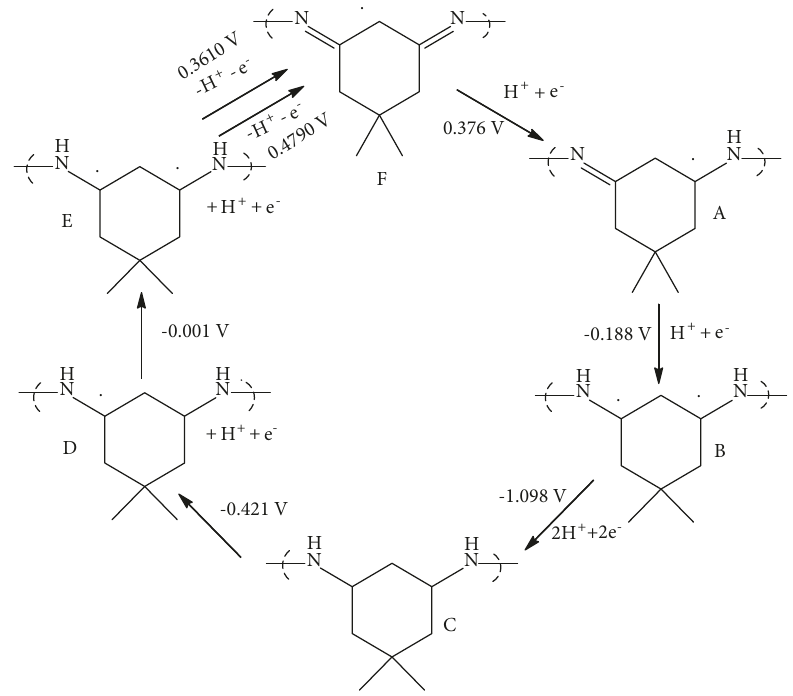
Figure 3: Redox mechanism occurring at azomethine moiety of DmChDp.